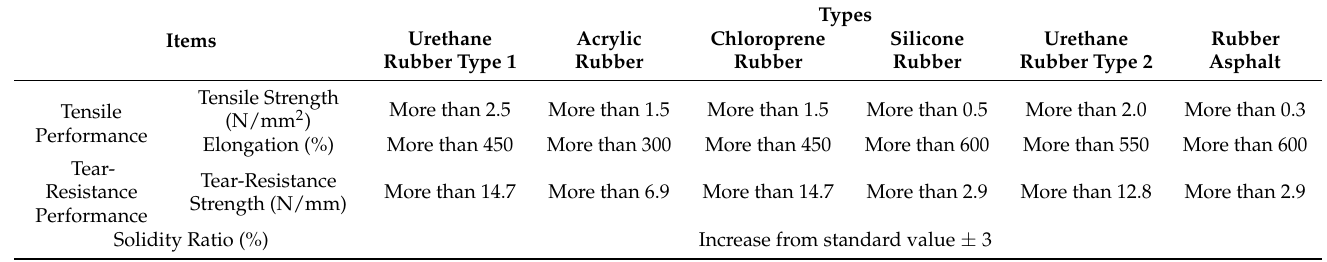
Table 4. KS F 3211—quality standards for basic physical properties [13].